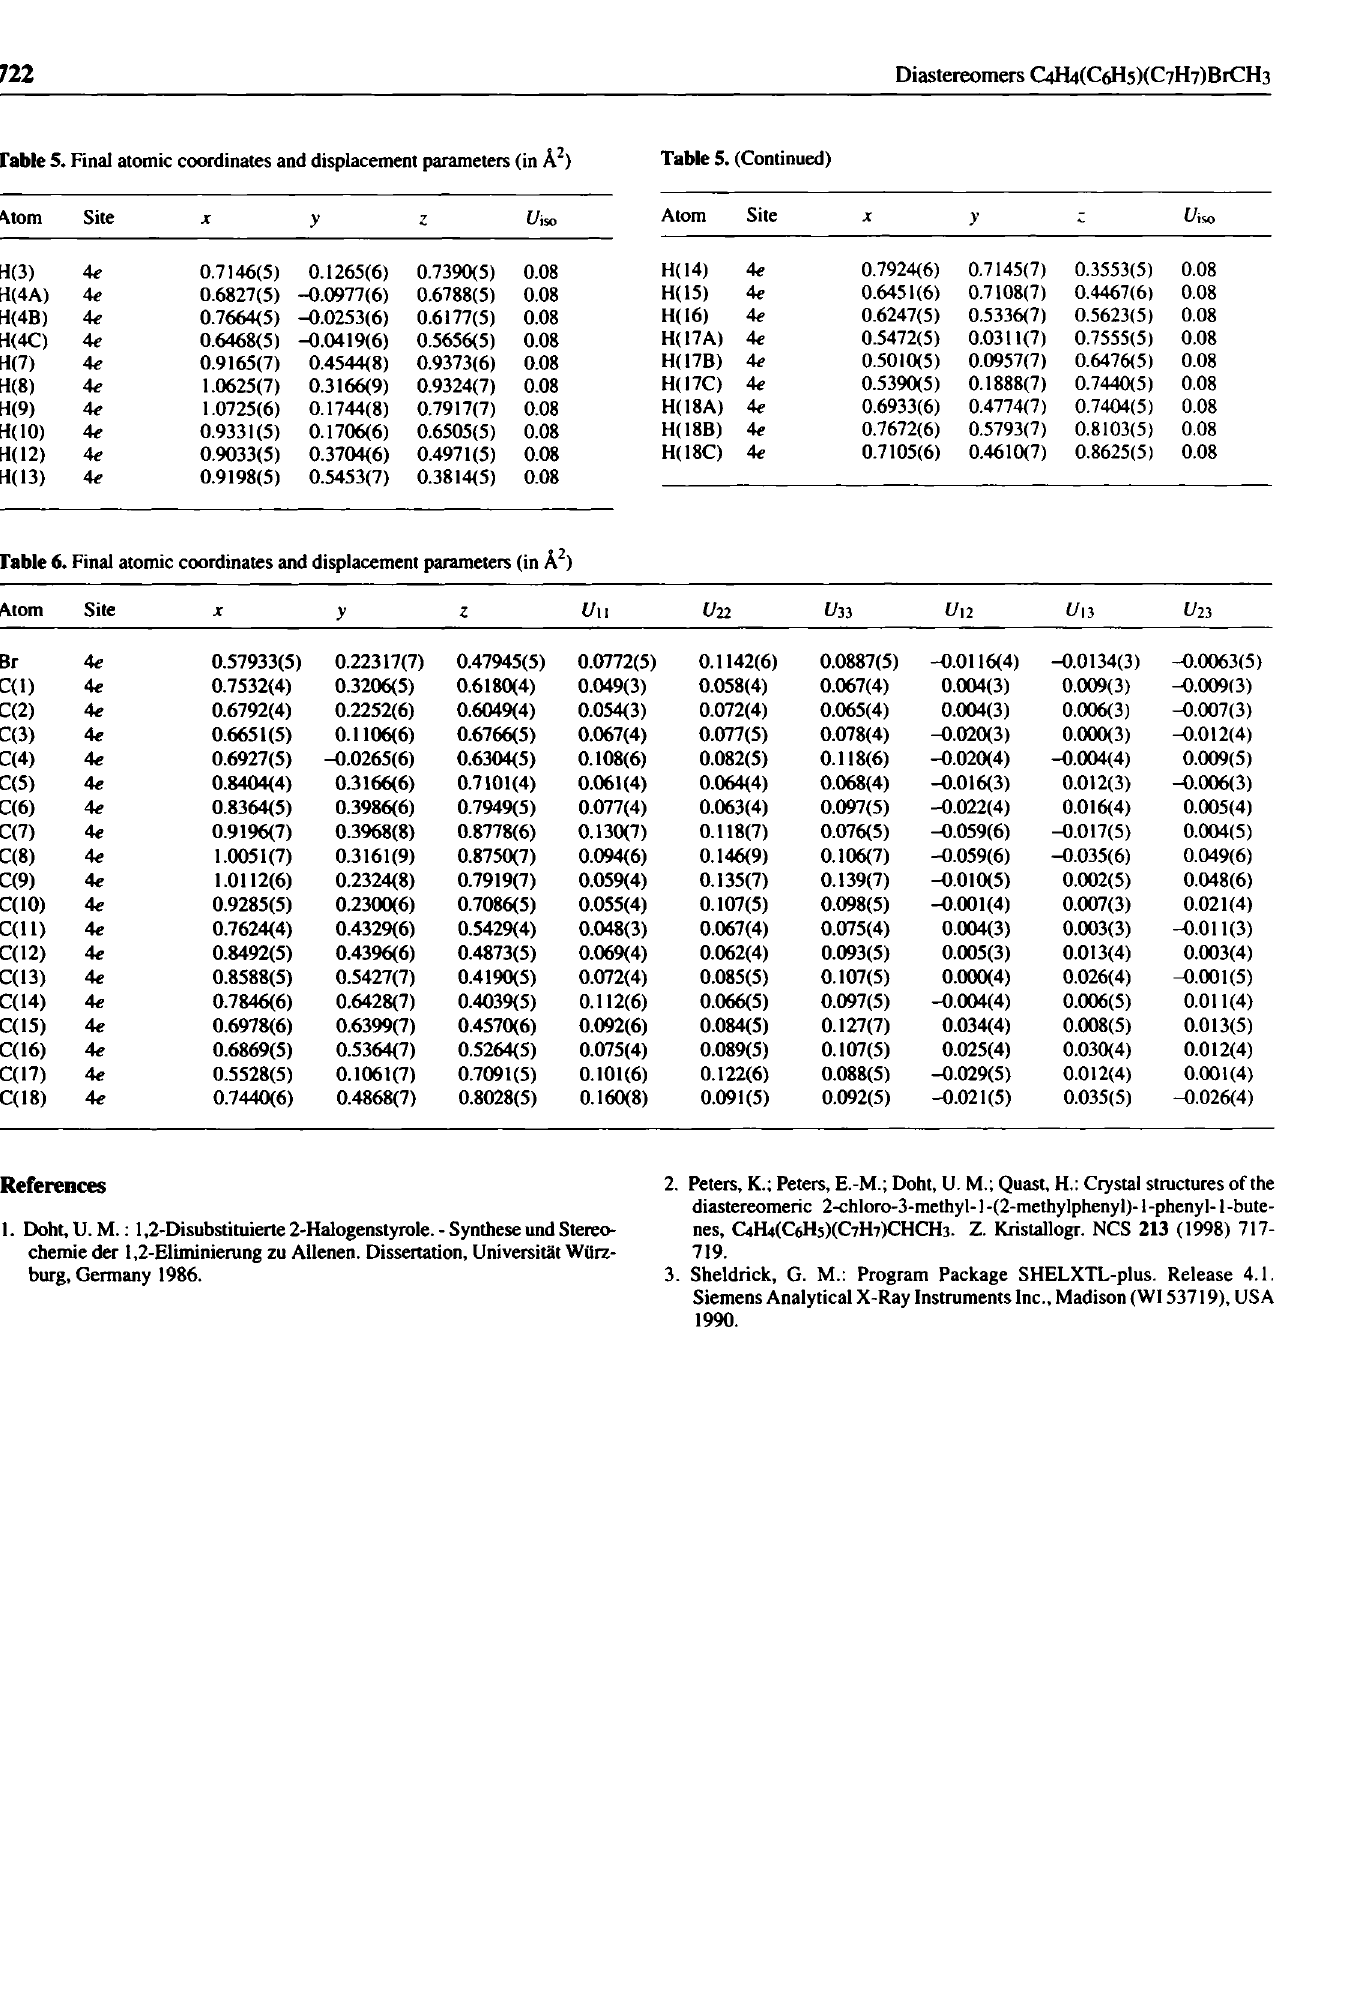
Table 5. Final atomic coordinates and displacement parameters (in Â^) Table 5. (Continued)